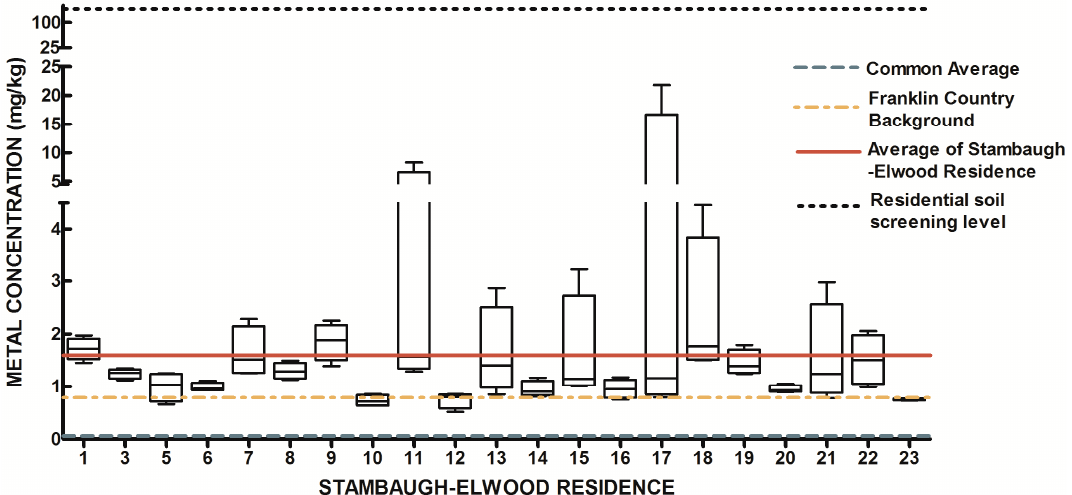
Figure 12. Residential urban soil level of Cd in the Stambaugh-Elwood community versus Franklin County (background), common averages and residential screening levels (RSLs) (mg/kg soil). Soil samples were taken from 21 of 46 residences that consented for the study in compliance with OSU